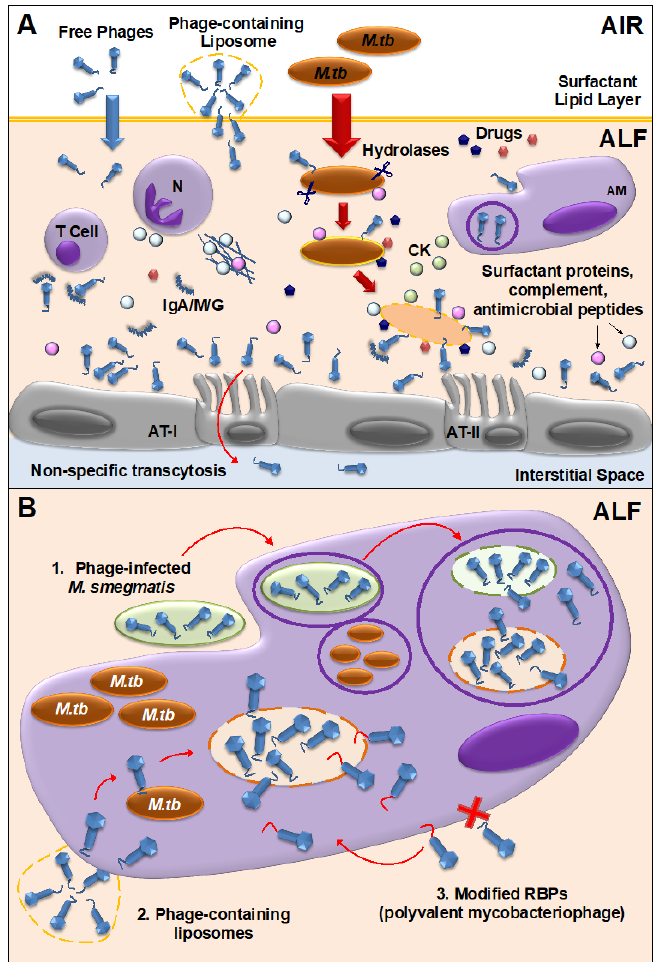
Figure 2. Mycobacteriophage- M. tuberculosis interactions in the human lung alveolar environment. ( A ) Free and/or encapsulated mycobacteriophages (e.g., in liposomes) reach the lung alveolar space, cross the surfactant lipid layer and are bathed in alveolar lining fluid (ALF), where they can directly or indirectly interact with innate immune cells, generating a local immune response. Some phages will be cleared by phagocytic cells [e.g., alveolar macrophages (AMs)], or by neutralizing antibodies (IgA/M/G). If delivered in sufficient numbers, mycobacteriophages are capable of binding glycan residues in the mucus layer secreted by alveolar epithelial cells type II (AT-II) through Ig-like domains in their capsids, providing an extra non-host antimicrobial protection layer against M. tuberculosis infection. Mycobacteriophages can also be translocated to the interstitial space through the epithelium via a non-specific transcytosis mechanism. When M. tuberculosis enters the alveolar space, innate soluble molecules in ALF, including hydrolases (represented as scissors), modify the M. tuberculosis cell envelope, driving M. tuberculosis -host cells interactions. These ALF hydrolases-drive alterations will define de novo exposed M. tuberculosis surface receptors to be recognized by mycobacteriophages. Here is depicted a combined mycobacteriophage-drug therapy, where drugs and mycobacteriophages work together with an activated mammalian immune response [including neutrophil (N) degranulation and neutrophil extracellular traps [180] secretion, AMs activation, and cytokine and chemokine secretion] to kill M. tuberculosis and control the infection. ( B ) Different strategies can be used to deliver mycobacteriophages inside mammalian cells (e.g., AMs) to access intracellular M. tuberculosis : (1) Mycobacteriophage-infected M. smegmatis bacilli acting as vehicles are phagocytized by AMs being delivered into M. tuberculosis -containing phagosomes. Replicating mycobacteriophages within M. smegmatis lyse the bacterium accessing the phagosome lumen where they recognize, infect and subsequently lyse and kill M. tuberculosis ; (2) Liposome-associated mycobacteriophages, which infect mammalian host cells more efficiently than free phages; (3) Generation of polyvalent mycobacteriophages through receptor binding protein (RBP) engineering to recognize mammalian immune cells in addition to receptors on the M. tuberculosis cell envelope surface. Note: This figure depicts a general overview of the mycobacteriophage- M.tb interactions in the human lung environment and with the mammalian immune system; and thus, does not fully represent the complexity of the processes described in the text.